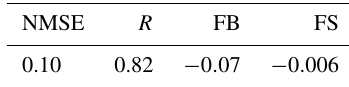
Table A3. Statistical evaluation of the APUGRID model employing the quasi-experimental eddy